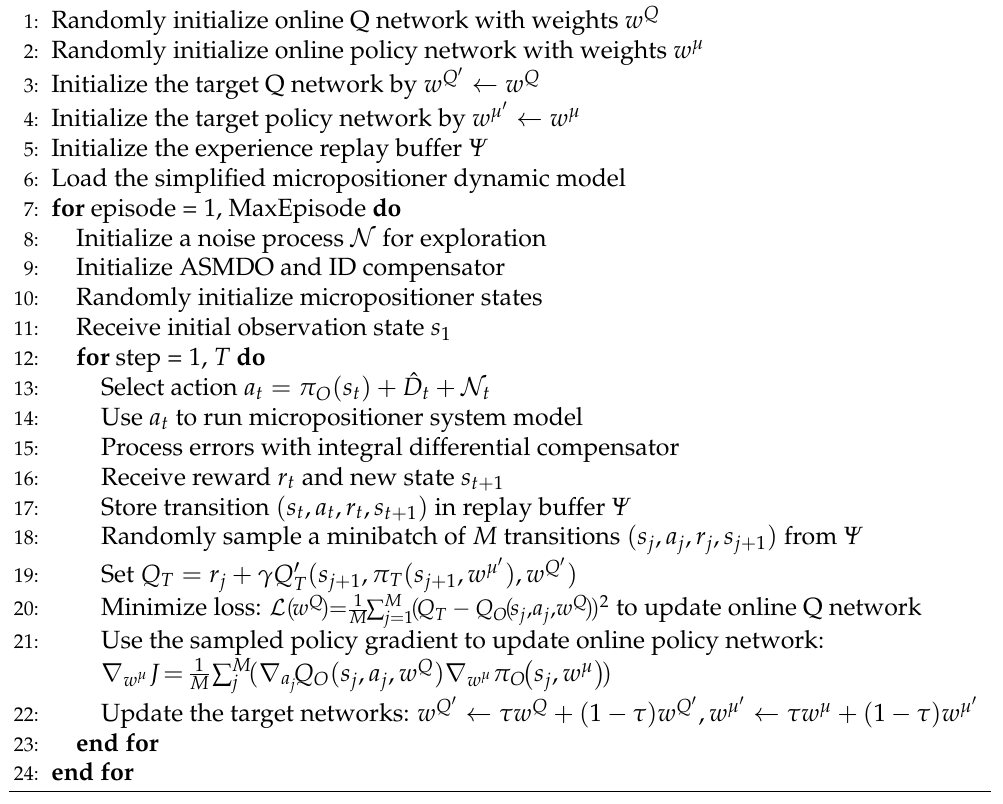
Algorithm 1 DDPG-ID